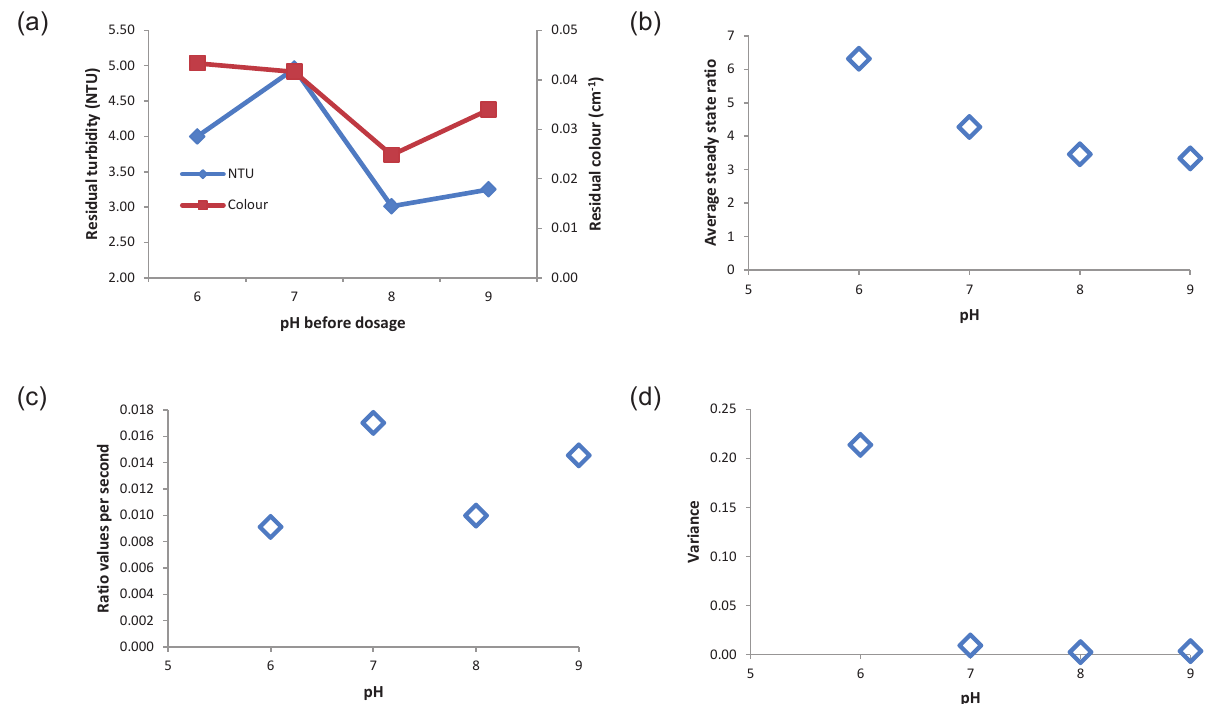
Figure 3. Optimization of pH – (a) residual turbidity and colour; (b) average steady-state ratio; (c) aggregation rate; (d) steady-state variance.